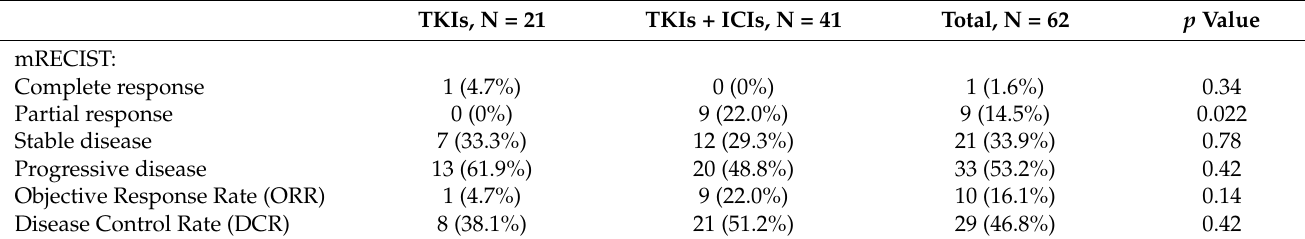
Table 2. Best response of TKIs and TKIs + ICIs, N = 62 (%).